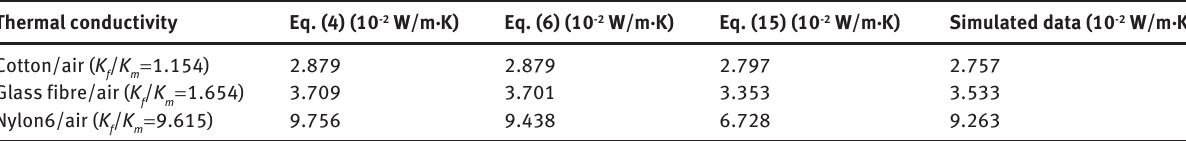
Table 4 Comparison of predictions [Eqs. (4), (6), and (15)] and simulations (CFD) for the thermal conductivity of hexagonal fibre array = 0.714). ( V f